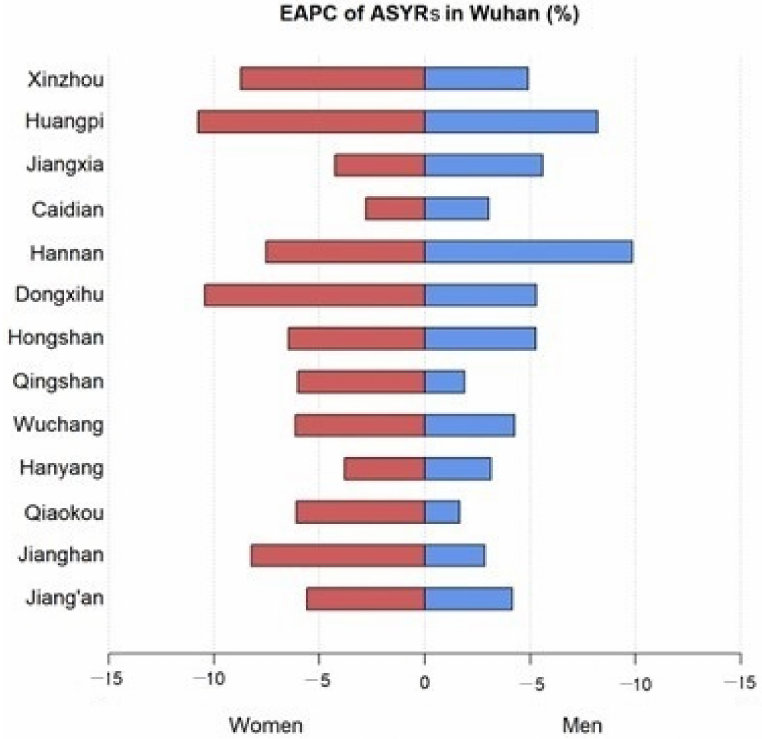
Figure 6. EPACs of ASYRs among women and men in the districts of Wuhan.